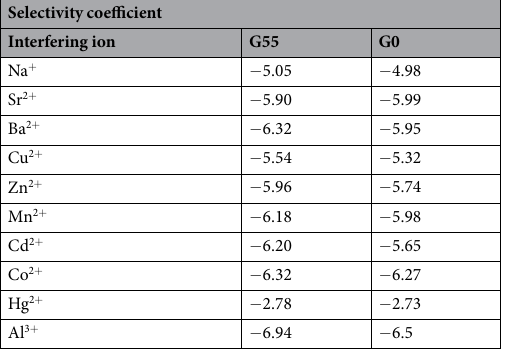
Table 4. Selectivity coefficients for silver ion-selective electrodes G55 and